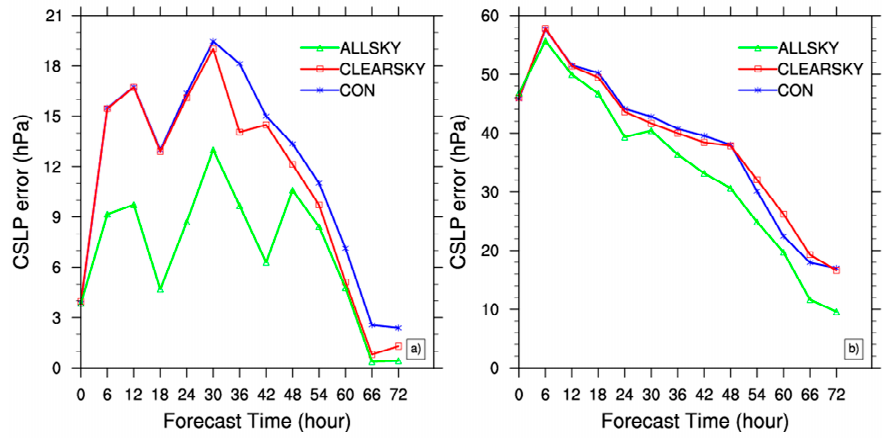
Figure 9. 72-h forecast track errors (experiment data minus best-track data, km) from CON (blue), CLEARSKY (red), and ALLSKY (green) experiments for ( a ) Chan-hom and ( b ) Nangka, starting from 1800 UTC 9 July.